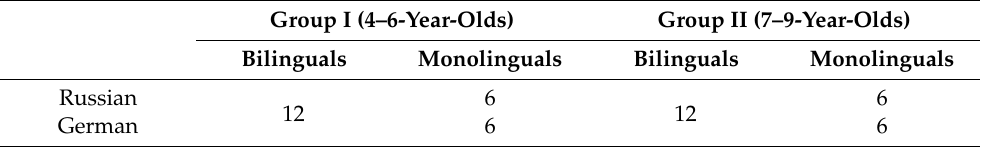
Table 1. Participating